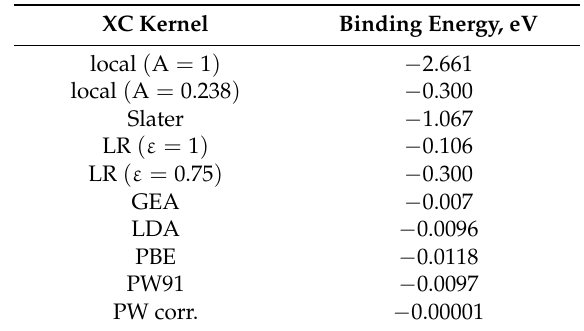
Table 2. Excitonic energies (in eV) in 1L MoS 2 obtained with different XC kernels. The